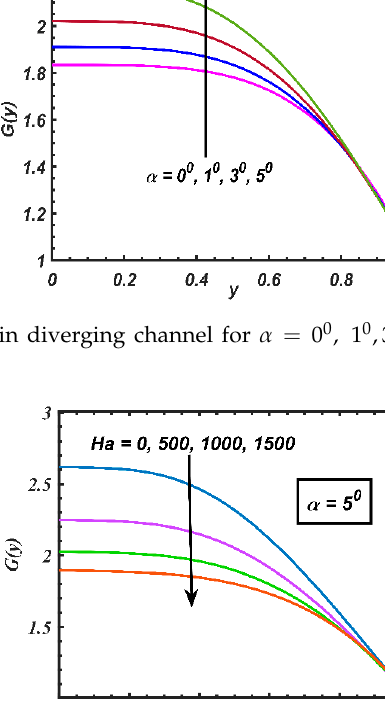
Figure 6. Variation of G(y) in diverging channel for H = 0, 500, 1000, 1500 and Re = 100,Pr = 5, α = 5 0 , Ec = 0.5.